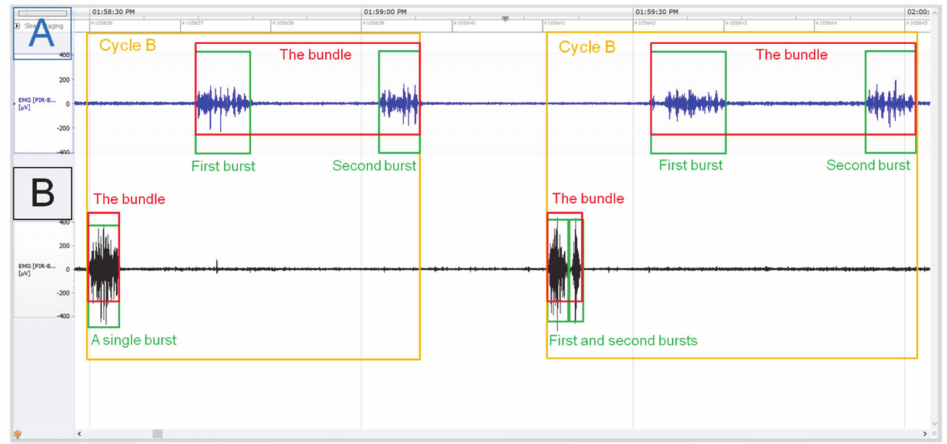
Figure 2. The representative images of the EMG signal recording in the reticulo-rumen, representing cycle B. Myoelectrical activity of the rumen ( A ); myoelectrical activity of the reticulum ( B ). NeuroScore analysis software, 1-min timeline.